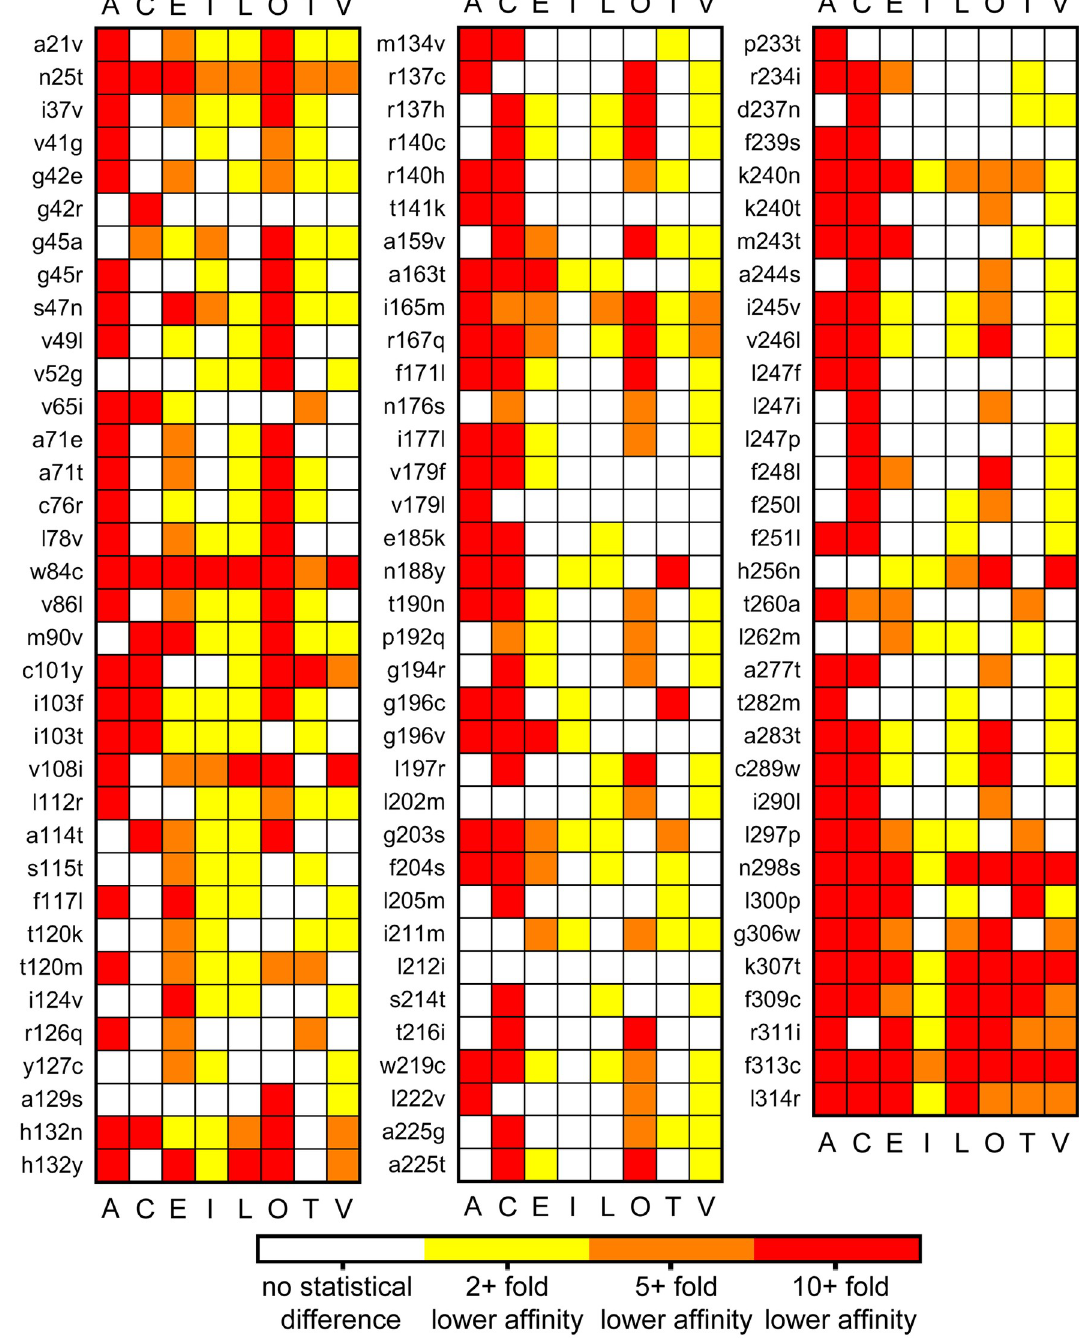
Fig 8. Heatmap of the predicted effect of hAT 1 R nsSNPs on ARB affinity. Each ARB, denoted by the first letter of their name, with EXP3174 marked as L for Losartan, was docked to single polymorphisms induced into the apo-AT 1 R model. The polymorphism is listed on the left of each column. Data are colored, as per the key, only if there is a statistical difference between the Boltzmann weighted average affinities (n = 6) of the apo-AT 1 R model and indicated polymorphism as determined by a one-way ANOVA followed by Kruskal-Wallis Multiple-Comparison Z-Value